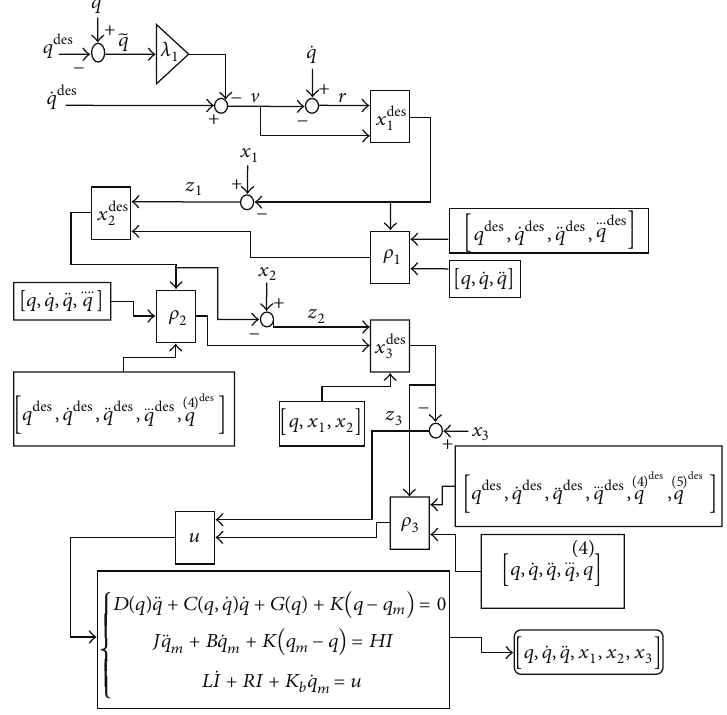
Figure 1: Block diagram of the exponential tracking control structure.